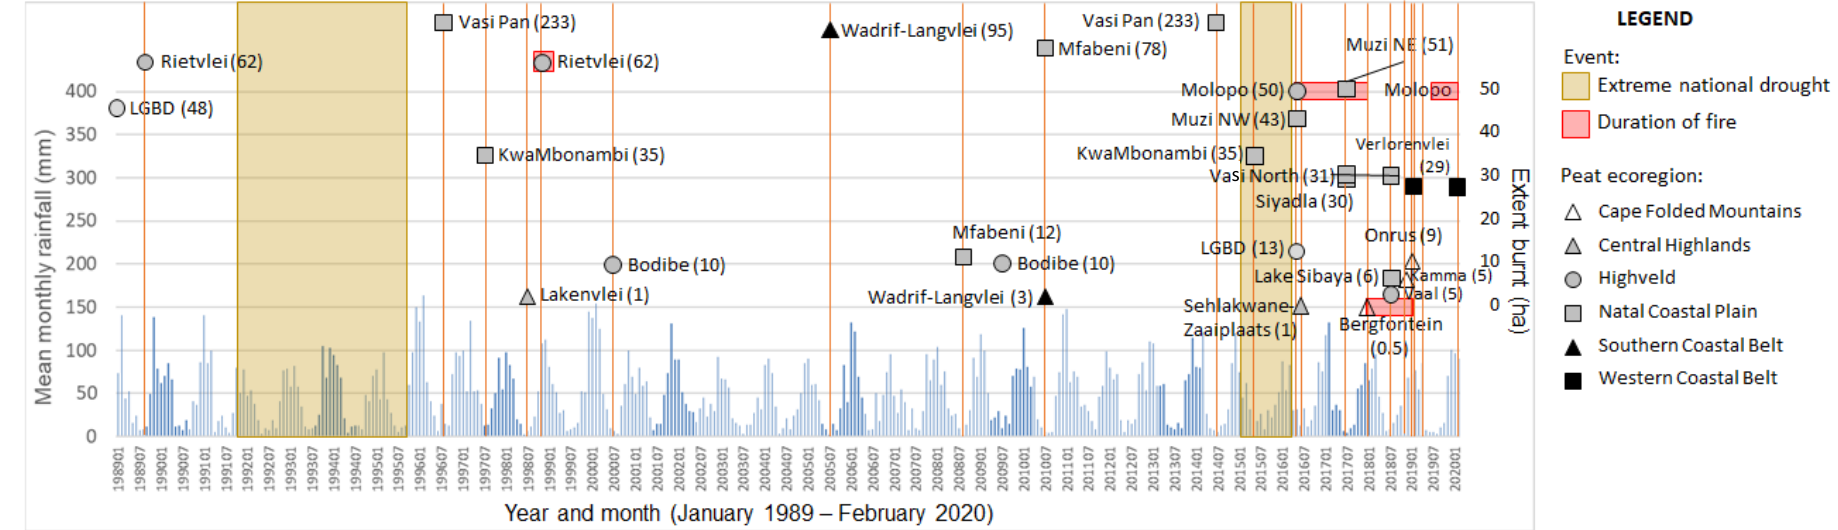
Figure 4. The sequences of mean monthly rainfall for South Africa (below) and observed peat fires (plotted per peat ecoregion; above) for the 31-year period January 1989 to February 2020. The areal extents (ha) of the fires are shown in brackets. The timings of extreme decadal droughts which affected >25 % of the areal extent of South Africa (Malherbe et al. 2016) are also shown. The extents of peat fires were summarised from publications listed in Table A2; rainfall data were obtained from ARC-SCW (2020); and drought information from Malherbe et al. (2016). Where only the year of a fire is recorded in Table A2, the fire is assumed to have occurred in the driest month of the